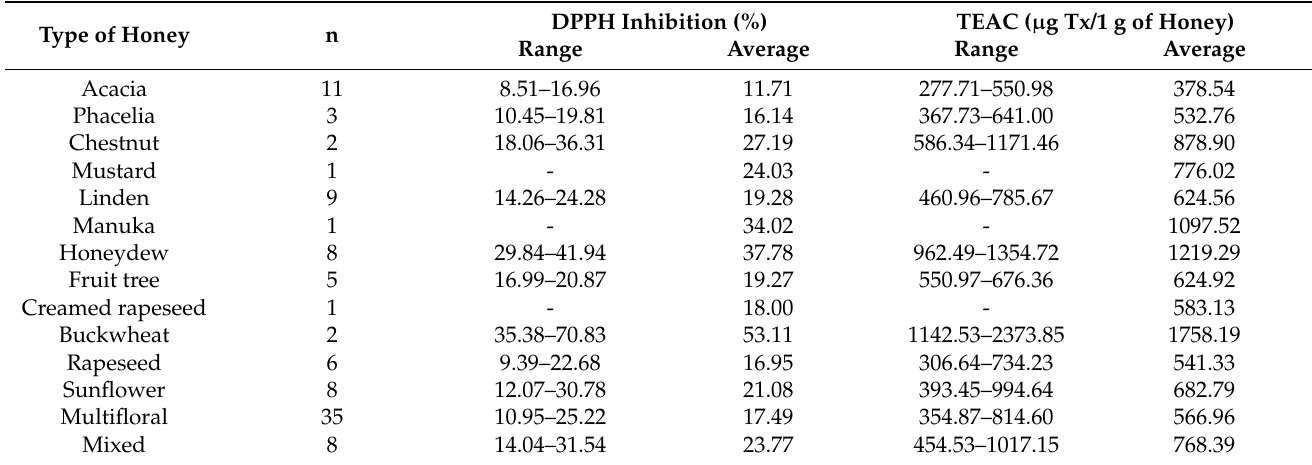
Table 12. Antioxidant activity according to the honey